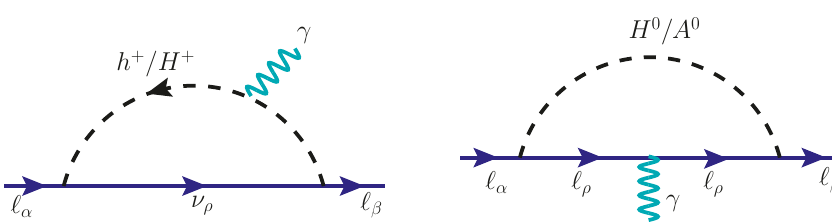
Figure 8 . One-loop Feynman diagrams contributing to ‘ (cid:11) scalar (left) and neutral scalar (right) in the Zee